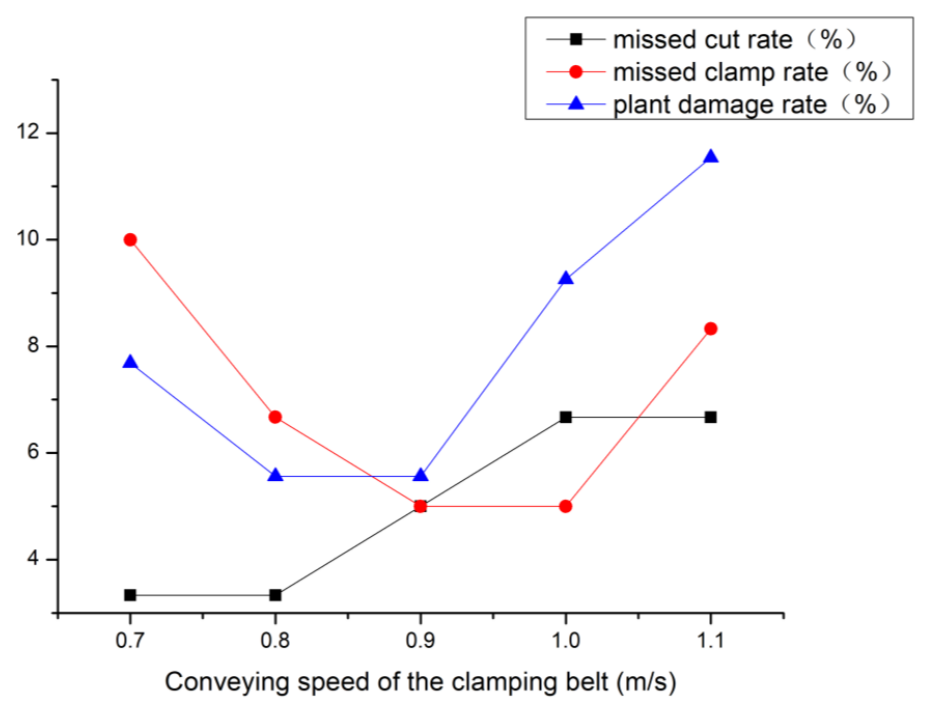
Figure 14. Effect of clamping belt conveying speed on harvesting performance.